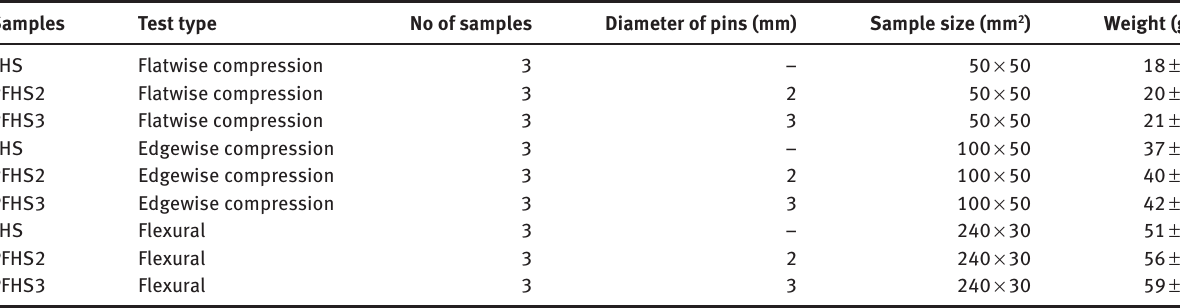
Table 2: Detail of samples for flatwise compression, edgewise compression and flexural tests.